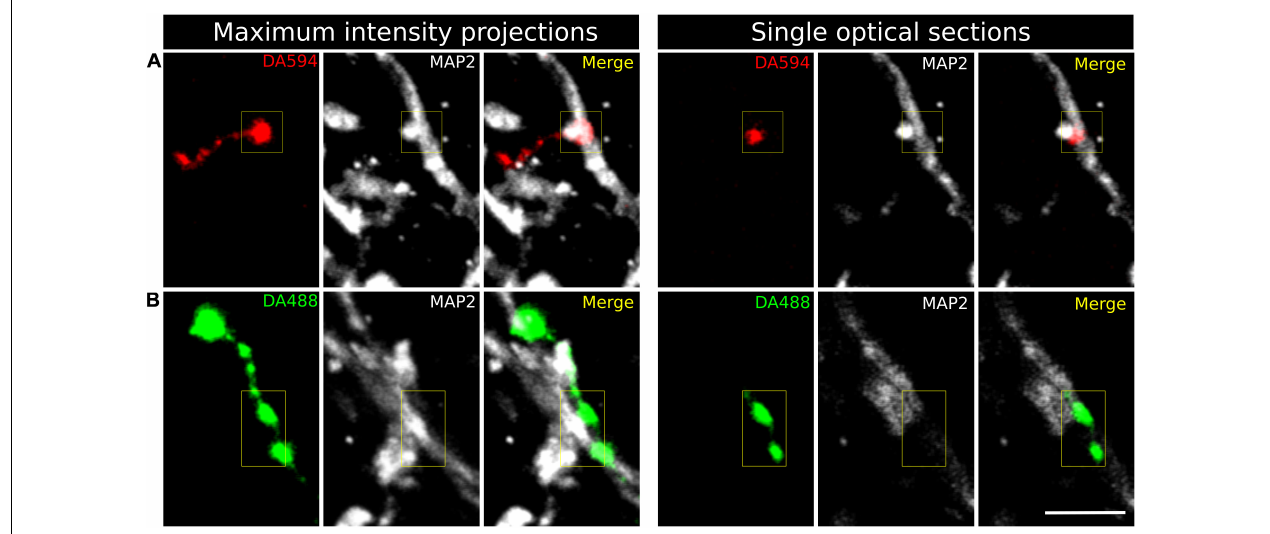
FIGURE 6 | Confocal fluorescence images of corticospinal axon varicosities in the gray matter of the C3 spinal segment. (A) Terminal varicosity from an axon arising in M1, labeled with Alexa 594-conjugated dextran (DA594). (B) En passant axonal varicosities from a terminal branch of a PM-arising axon injected with Alexa 488-conjugated dextran (DA488). Transverse spinal cord sections were processed for microtubule-associated protein 2 (MAP2) immunohistochemistry to visualize neuronal somas and dendrites (white). Maximum intensity projections were obtained from a z-stack of twelve serial optical sections separated 0.84 µ m. Scale bar, 5 µ